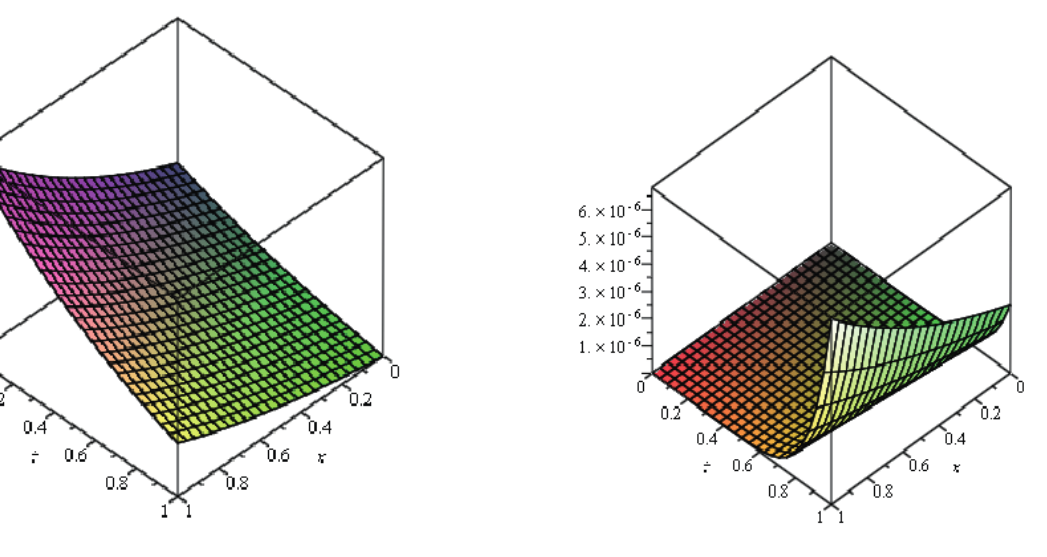
Fig. 3: Error E 8 ( U ) = | Exact − Approximate | for Eqs.